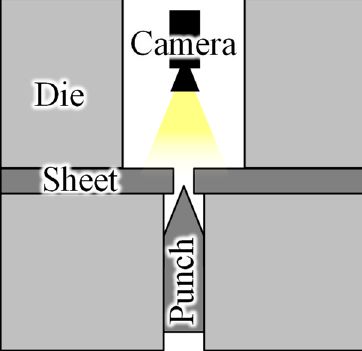
Figure 7. HET process: ( a ) schematic of HET and ( b ) area measurement after crack occurrence.